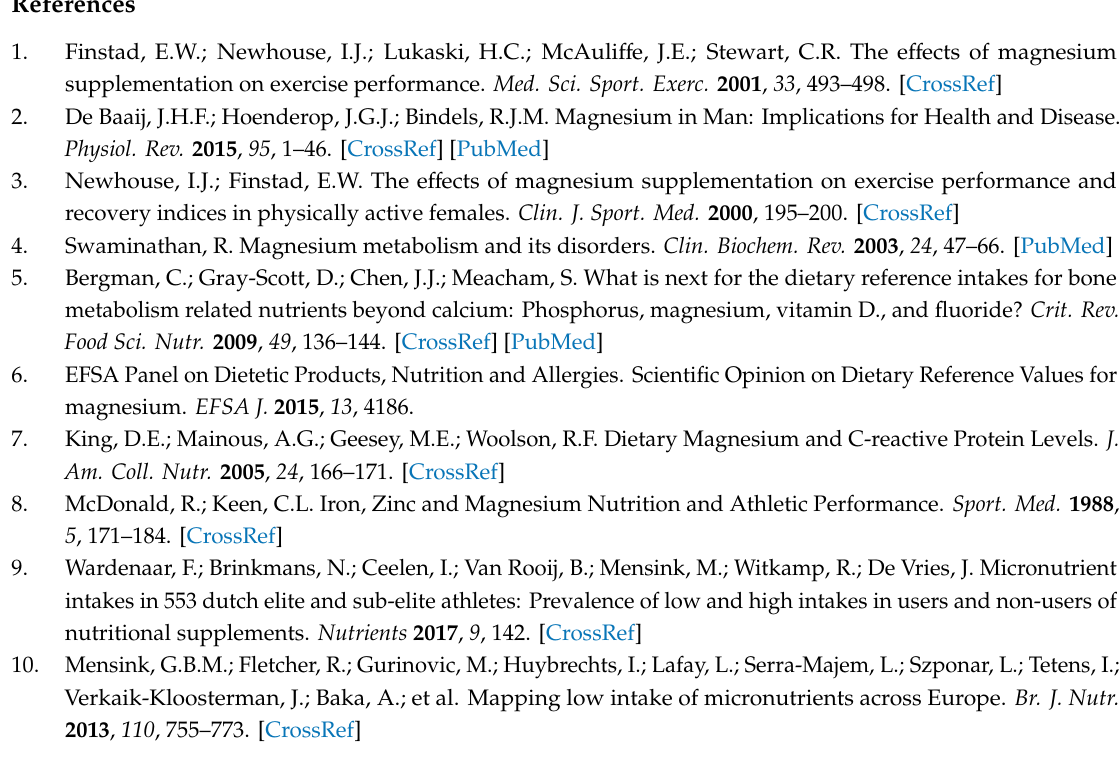
Table S1: Qualitative composition of the 15 magnesium formulations used in this